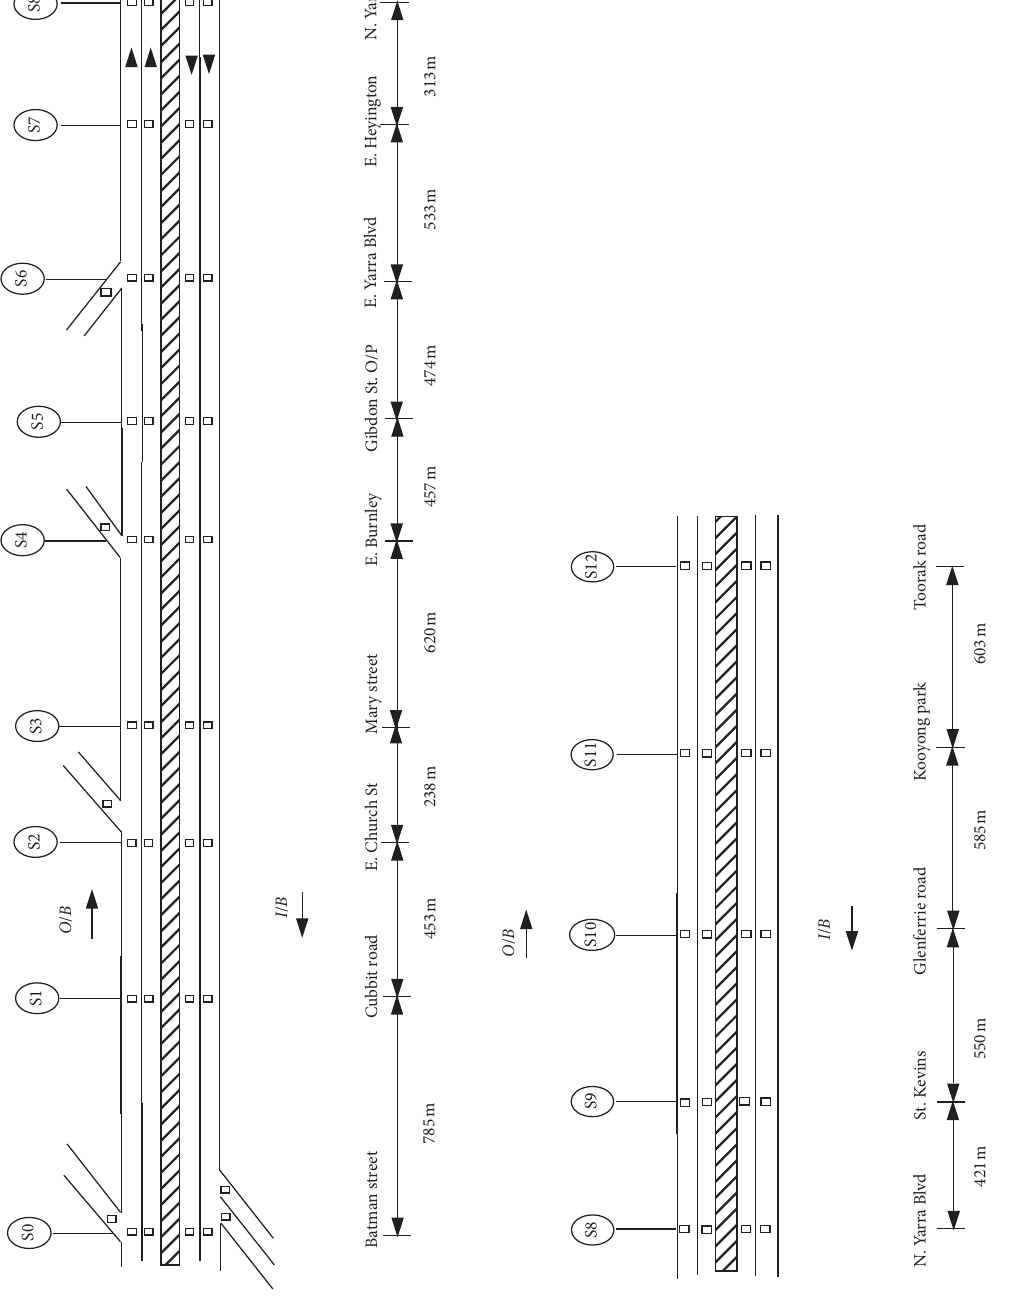
Figure 3: Schematic of the South Eastern